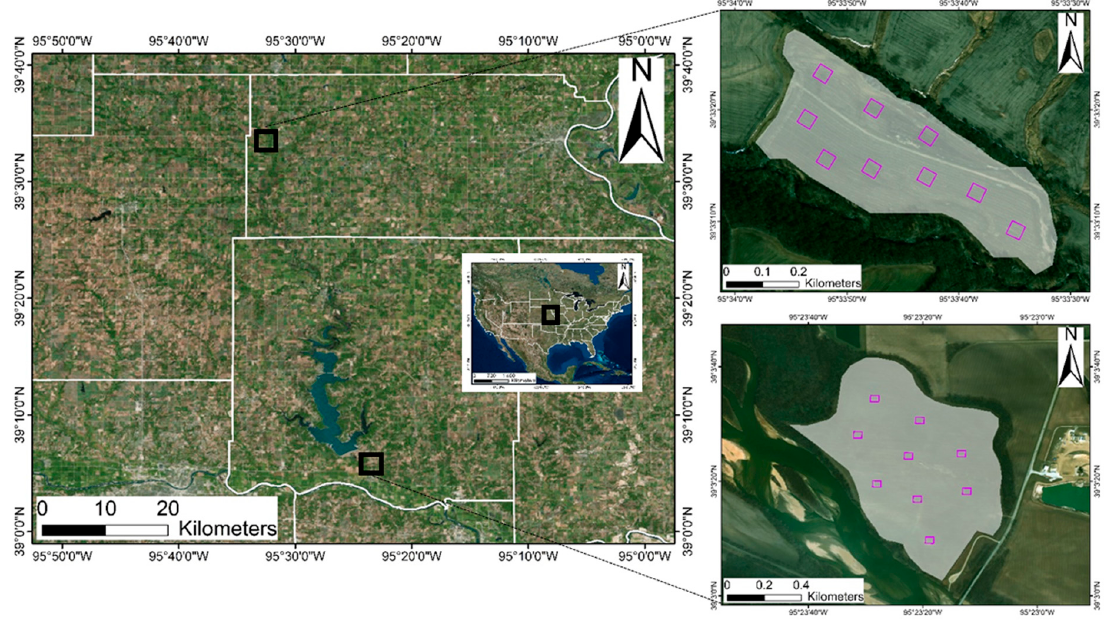
Figure 1. Left : On-farm fields located in the northeast region of Kansas. Top-right : Site 1, Atchison, KS; bottom-right : Site 2, Jefferson, KS. Purple squares = field sampled areas. KS; bottom-right : Site 2, Jefferson, KS. Purple squares = field sampled